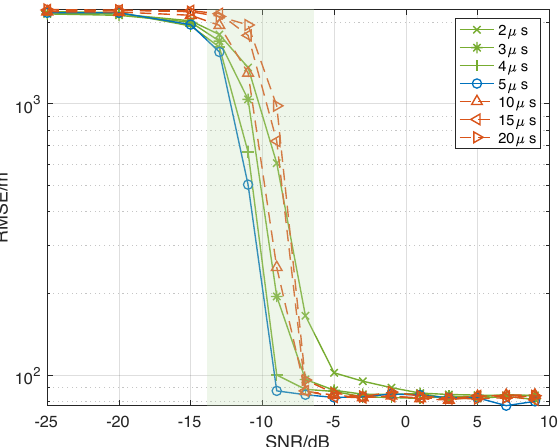
Figure 6. Root mean square errors (RMSEs) of estimated positions corresponding to different searched width cases against SNR from − 25 dB to 10